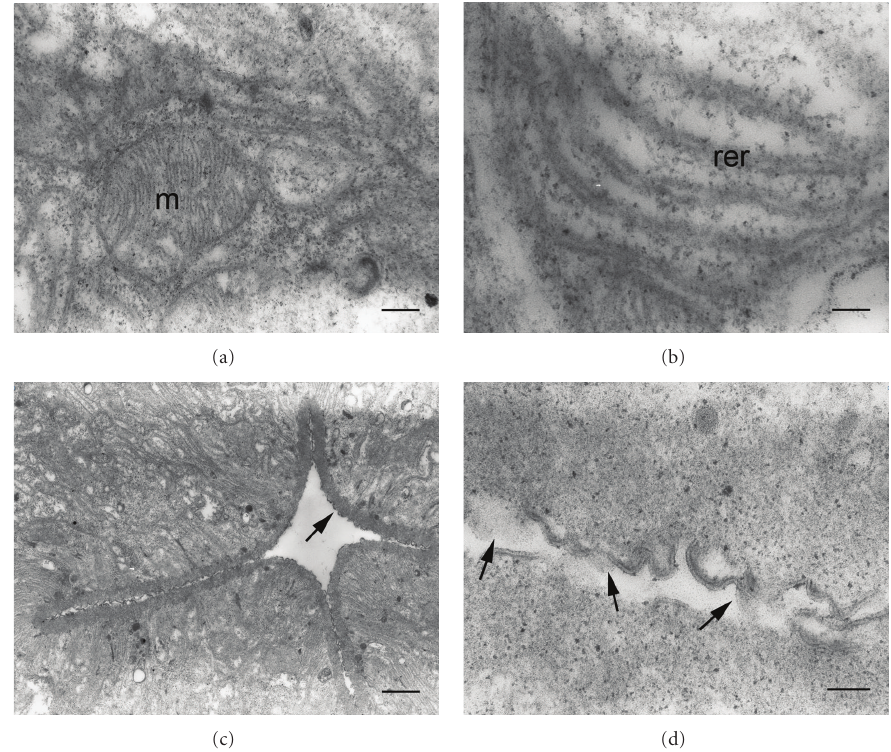
Figure 4: TEM micrographs of the salivary gland in adult male C. megacephala . (a) Salivary gland cell presenting mitochondria (m). Bar = 0.2 µ m. (b) Parallel arrays rough endoplasmic reticulum (rer). Bar = 0.1 µ m. (c) Gland lumen indicating an electron dense thick cuticle (arrow). Bar = 1 µ m. (d) High magnification of a cuticle exhibiting trace of secretory discharge into the lumen (arrows). Bar = 0.1 µ m.